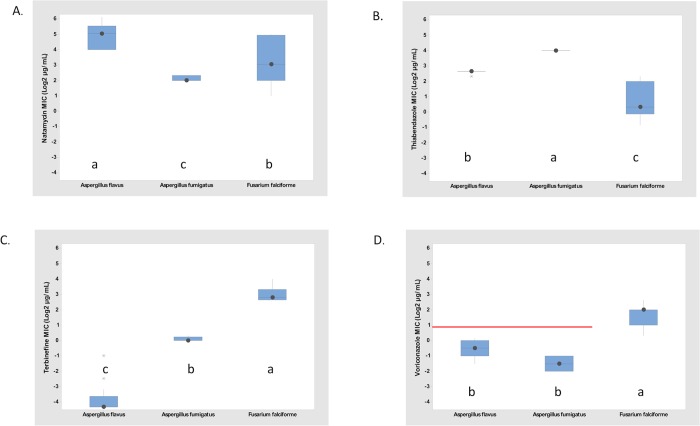
Fungal species boxplots of isolates sampled from equine fungal keratitis.A. Natamycin. B. Thiabendazole. C. Terbinafine. and D. Voriconazole. Minimal inhibitory concentration (MIC) values converted to log base 2 in parallel to the 2x dose steps used. ANOVA 2-factor Analysis: P values were all < 0.001 for fungus and antifungal main effects and for fungus x antifungal interaction. Mean separation of the fungus x antifungal interaction: Tukey mean with α = 0.05. Different letters indicate significant differences, CLSI susceptibility working breakpoint for voriconazole for Aspergillus is ≤1 μg/mL (red line). No breakpoints are available for natamycin, thiabendazole and terbinafine. Number of isolates: Aspergillus flavus: n = 13; Aspergillus fumigatus: n = 5; and Fusarium falciforme: n = 10.